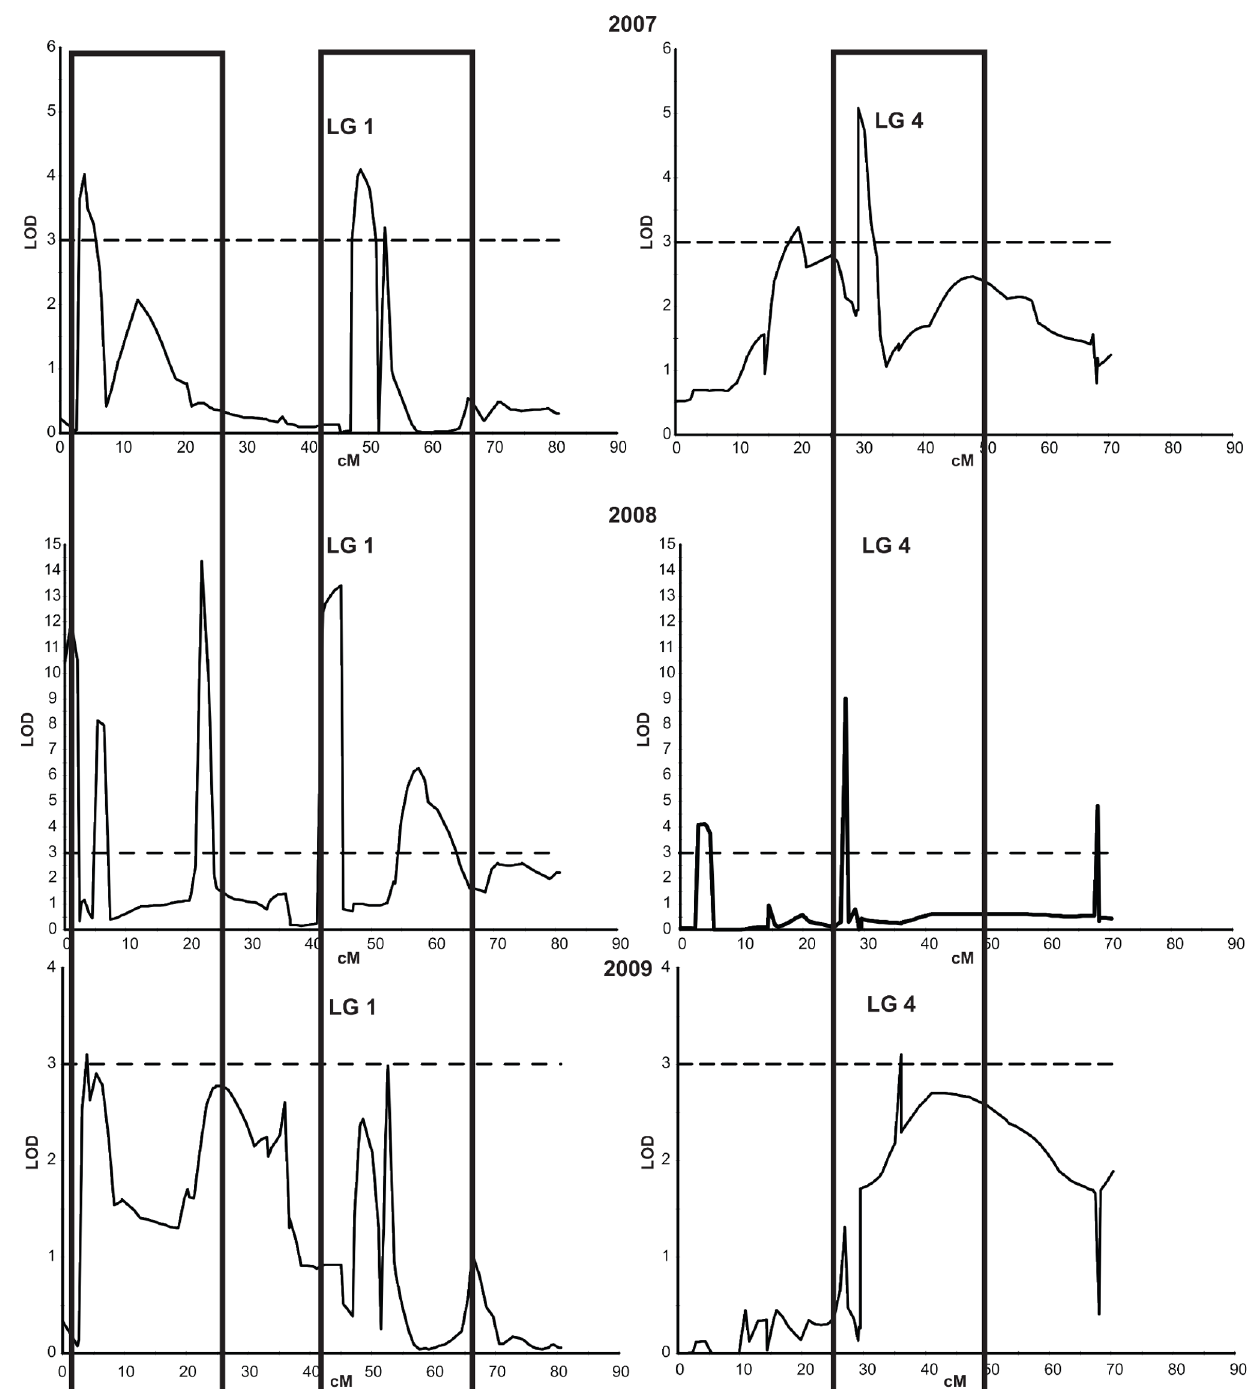
Figure 2. Description of the QTLs for the three years of evaluation. QTLs obtained for brown rot resistance in Pop-DF for three years in linkage group 1 (LG1) and linkage group 4 (LG4).